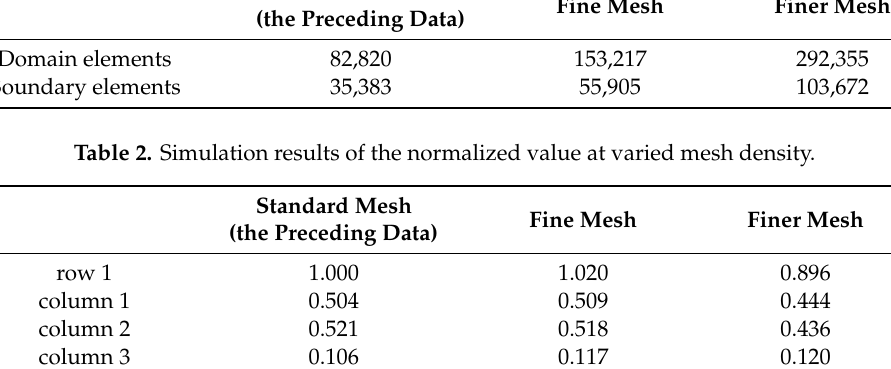
Table 2. Simulation results of the normalized value at varied mesh density.